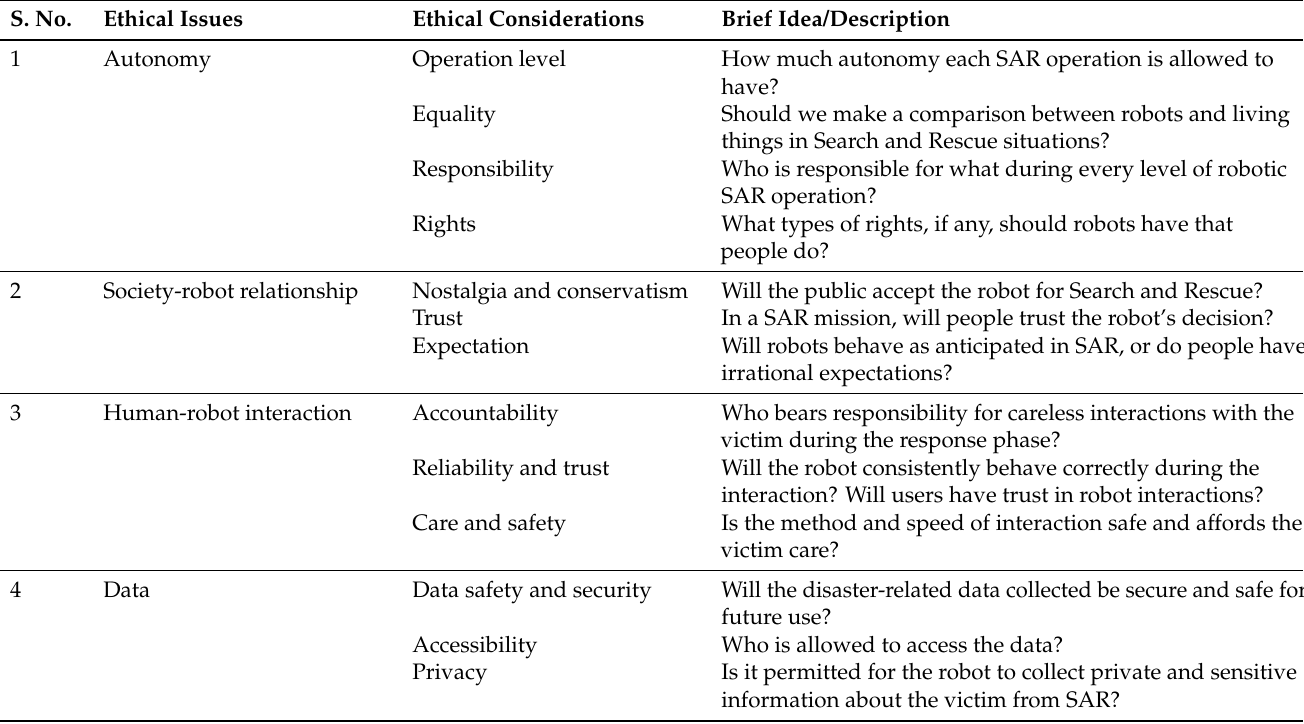
Table 1. Ethical framework for robotic SAR response phase